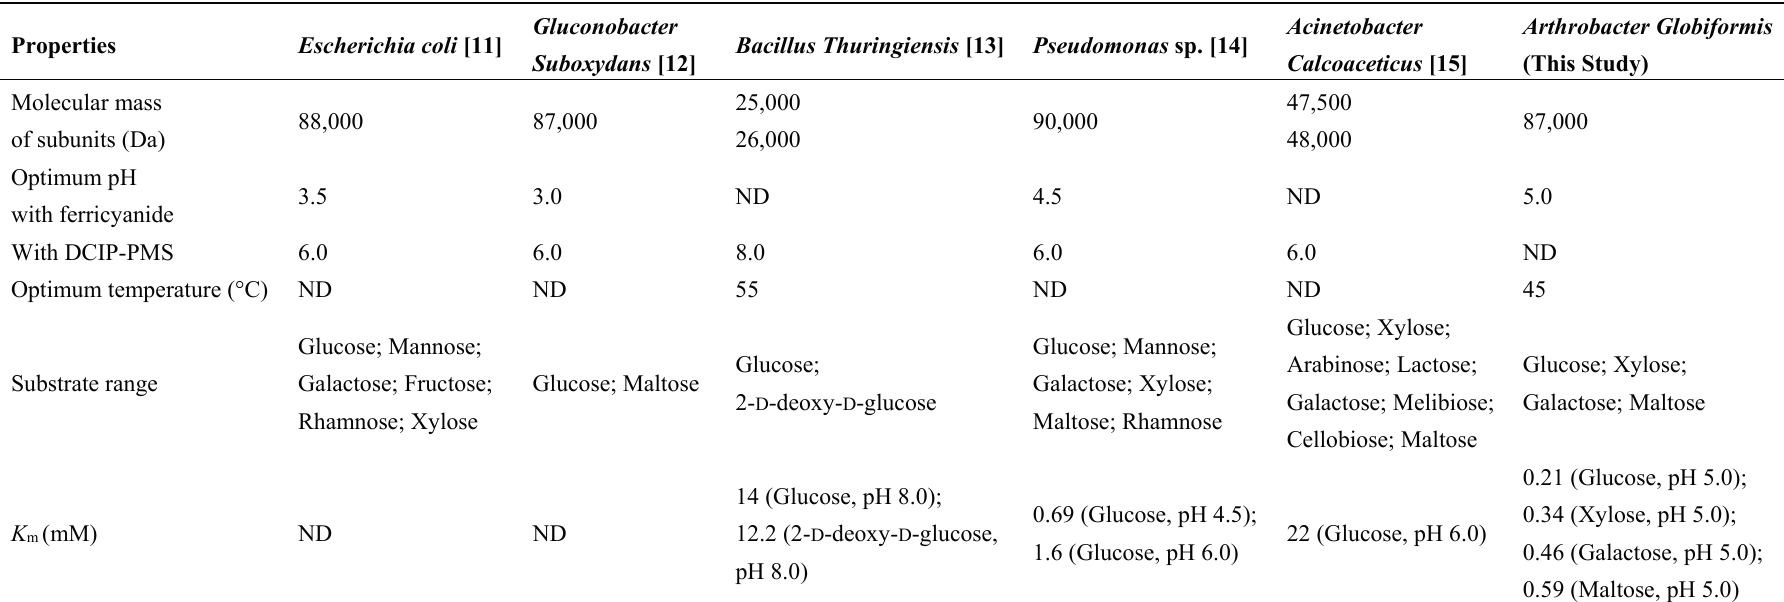
Table 5. Properties of GlcDHs from various